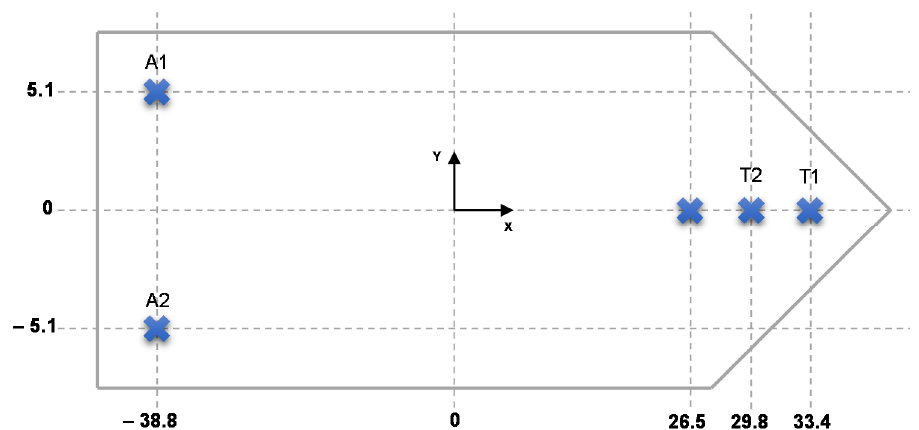
Figure 3. Distribution of thrusters on the ship. Table 5. Power consumption of individual thrusters. Thruster